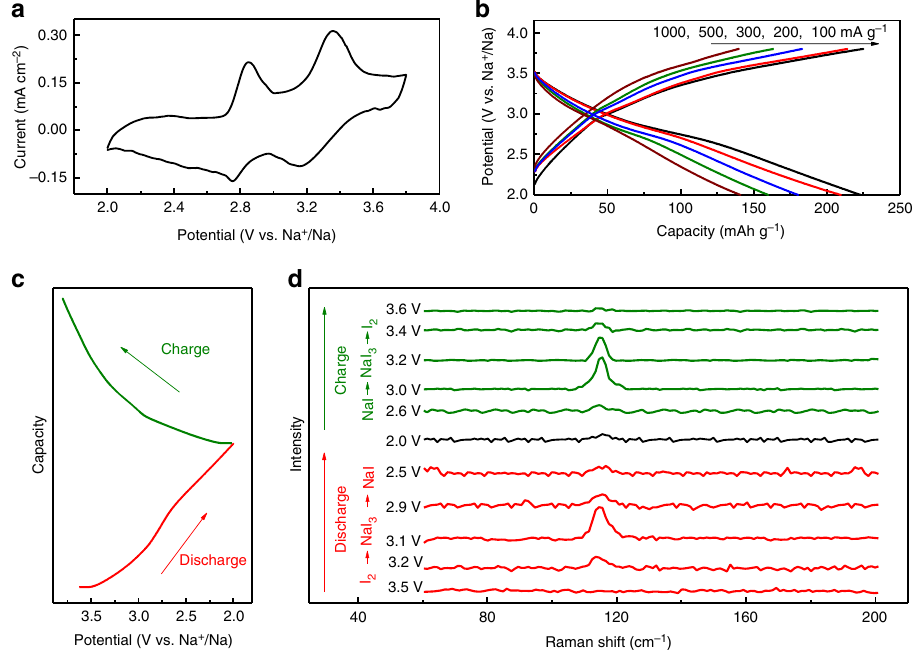
Fig. 4 Electrochemical performance of I 2 -HPCM-NP cathode for a Na – I 2 battery. a CV curve (0.1 mV s − 1 ) and b representative charge/discharge curves of I 2 -HPCM-NP cathode for Na – I 2 battery. c Discharge and charge curves with the test positions for analysis. d In situ Raman analyses of Na – I 2 batteries at different discharge and charge